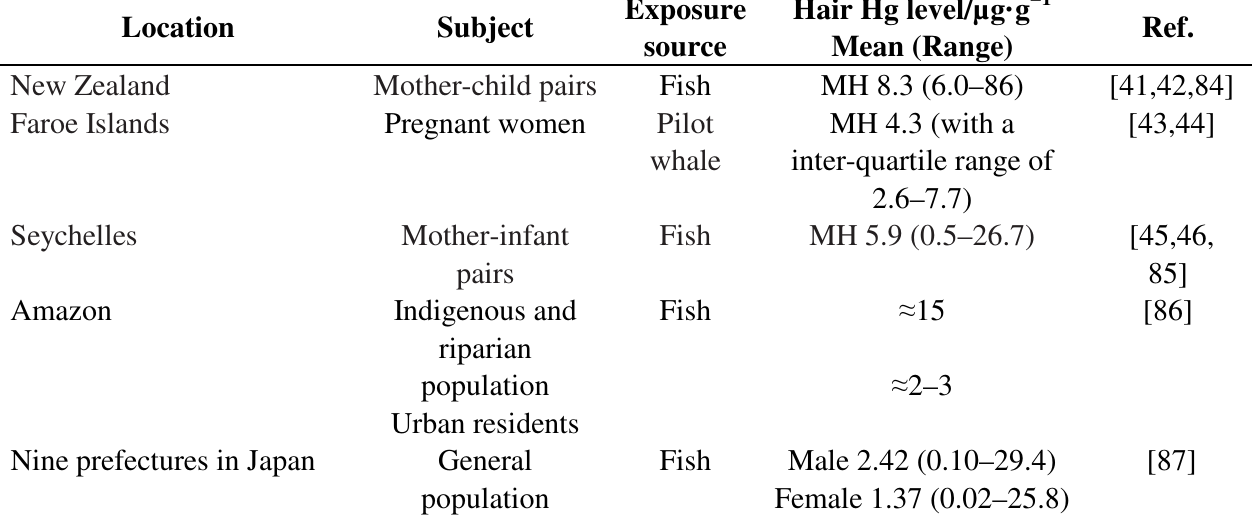
Table 3. The comparisons of hair Hg levels in fish and rice eating population over the